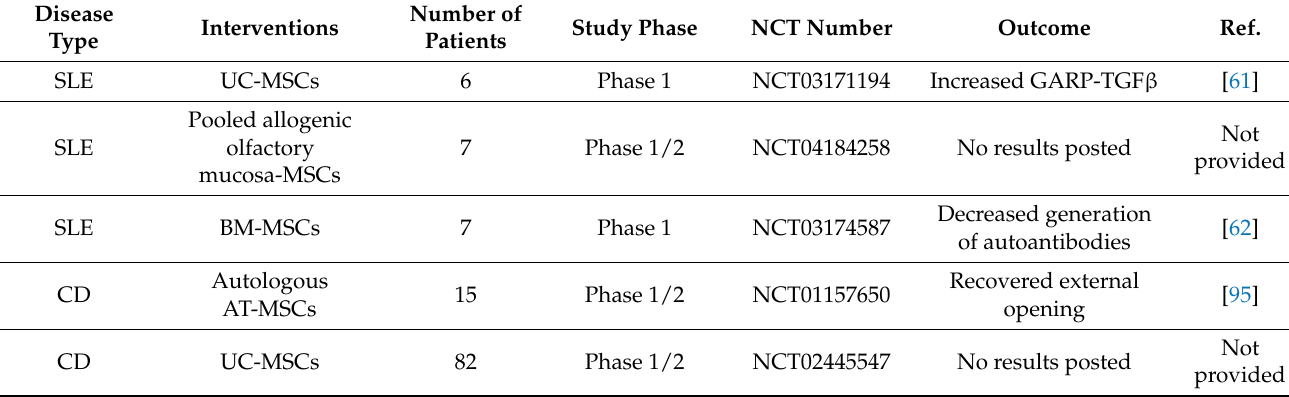
Table 1. Completed clinical trials of MSC-based treatment for immune